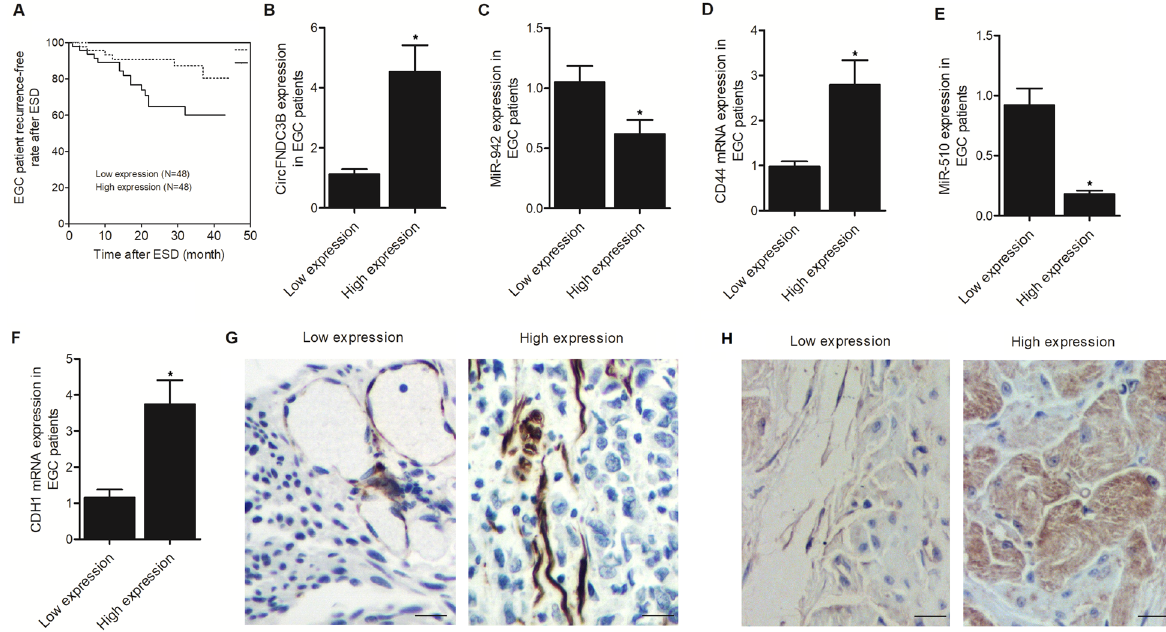
Figure 1. Expression of candidate genes in EGC patient groups (* P value < 0.05 vs. Low expression group). ( A ) The recurrence-free rate was lower in the High expression group (P value = 0.0174); ( B ) CircFNDC3B expression was higher in the High expression group; ( C ) MiR-942 expression was reduced in the High expression group; ( D ) CD44 mRNA expression was increased in the High expression group; ( E ) MiR-510 expression was decreased in the High expression group; ( F ) CHD1 mRNA expression was elevated in the High expression group; ( G ) IHC indicated higher CD44 expression in the High expression group (scale bar: 100 μm); ( H ) IHC indicated higher CHD1 expression in the High expression group (scale bar: 100